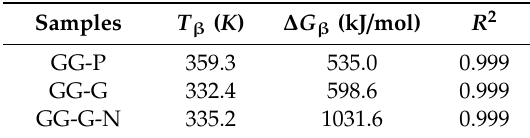
Table 3. Characteristics parameters for enthalpy–entropy relationships for sorption of GG-based films.